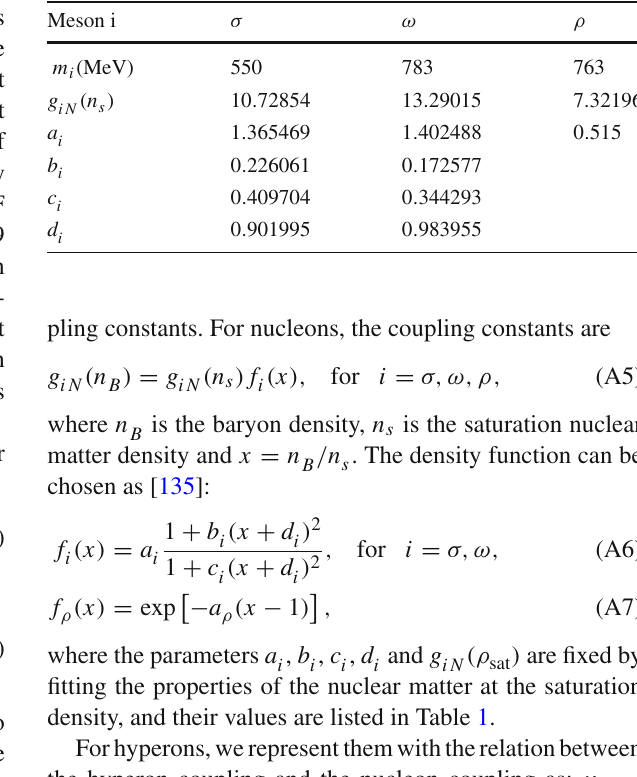
Table 1 Parameters of the mesons and their couplings (taken from Ref.